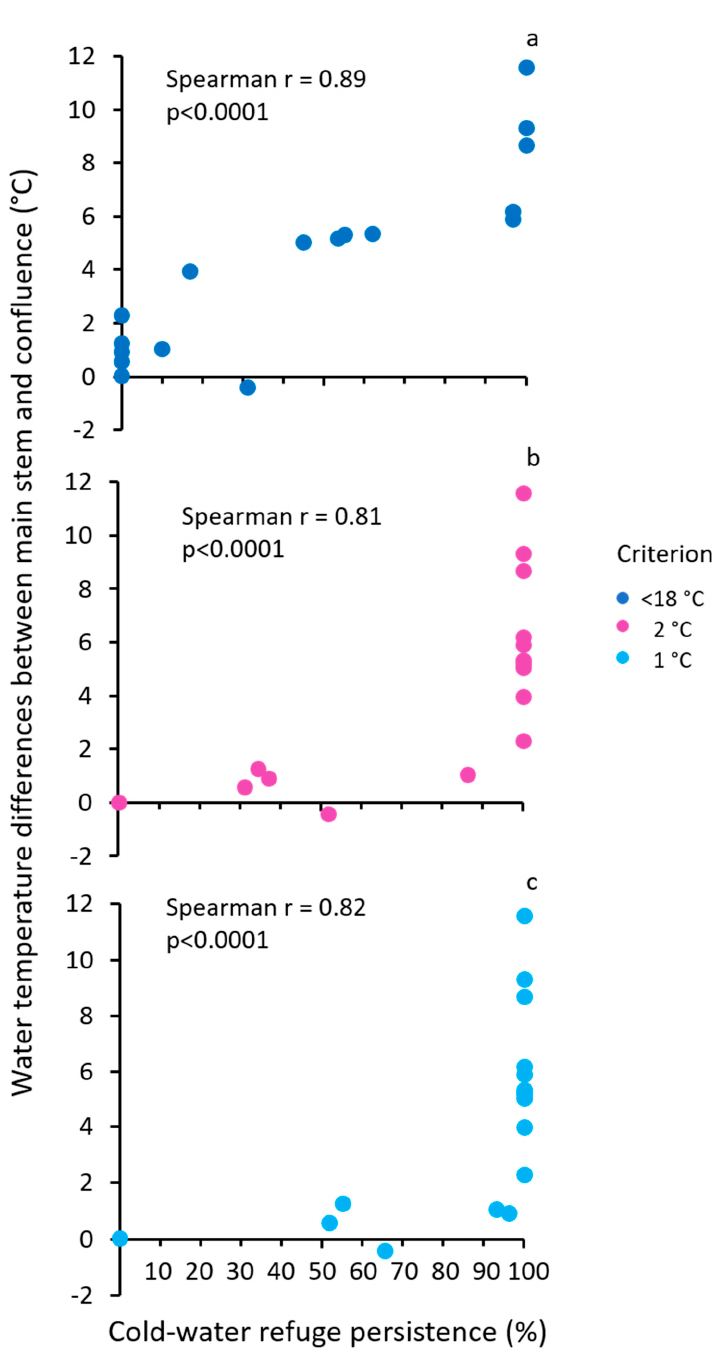
Figure 6. Relationships between persistence of cold-water refuges and bottom water temperature di ff erences (7DADM) between the main stem and confluences for three di ff erent cold-water refuge criteria: ( a ) Physiological, < 18 ◦ C, ( b ) ambient 2 ◦ C, and ( c ) ambient 1 ◦